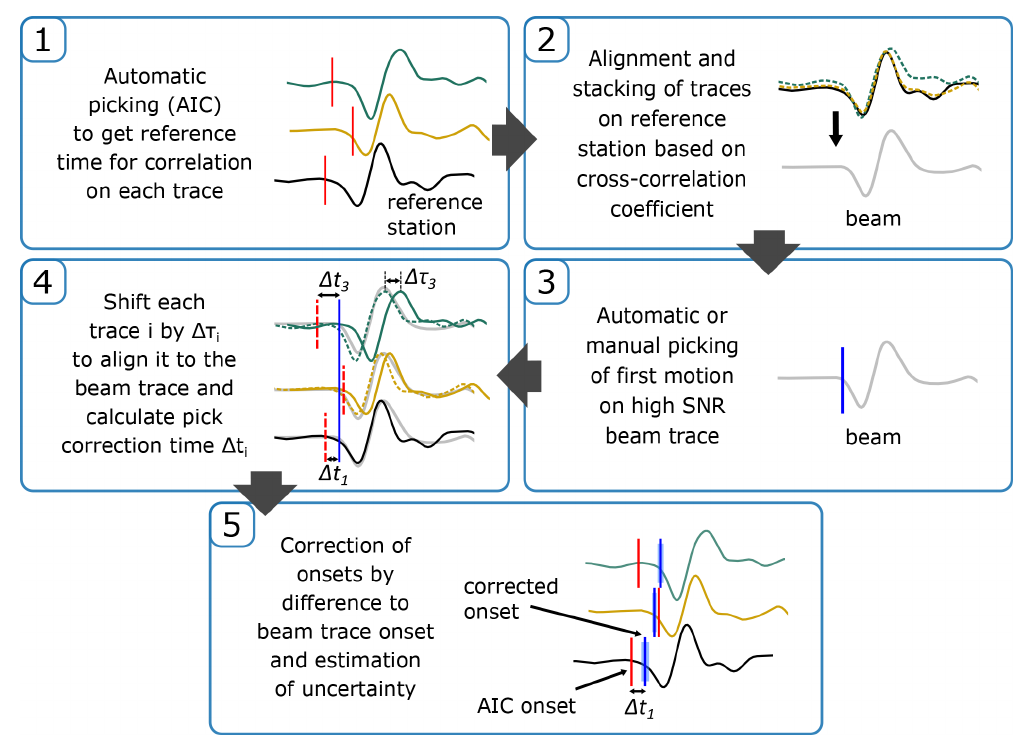
Figure 3. Workflow of the correlation picking algorithm. Solid lines show exemplary waveforms on three different stations. Black solid line shows reference station trace. Dashed lines of waveforms indicate that a waveform has been cut and shifted onto the reference (or beam) trace. Red vertical lines show reference AIC onset times, blue solid lines show corrected